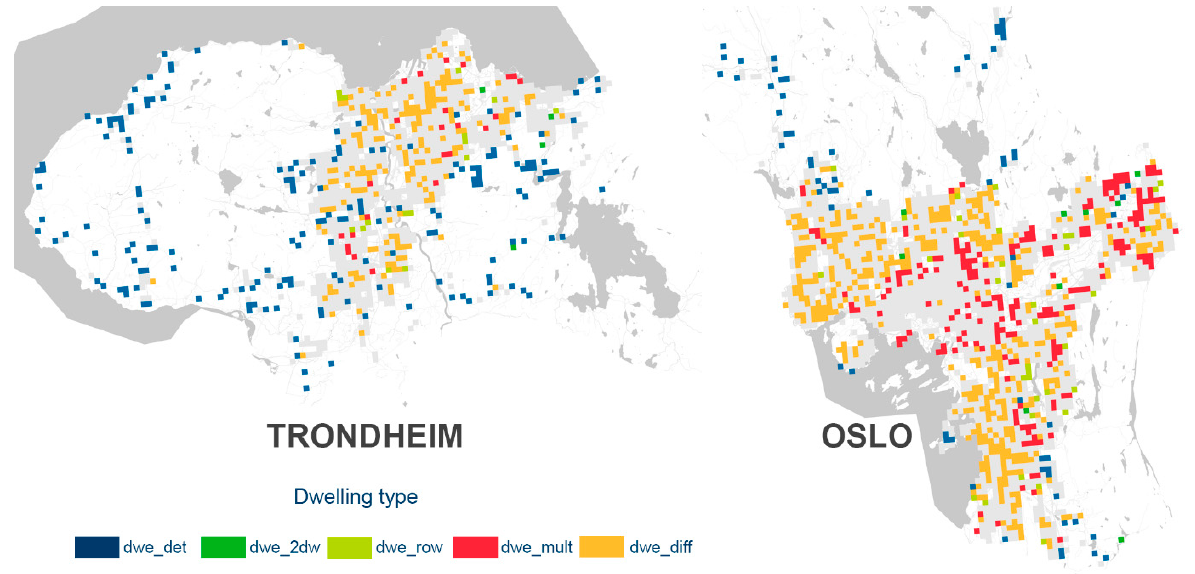
Figure 4. Grid cells that are homogenous regarding dwelling type (share of 100%).